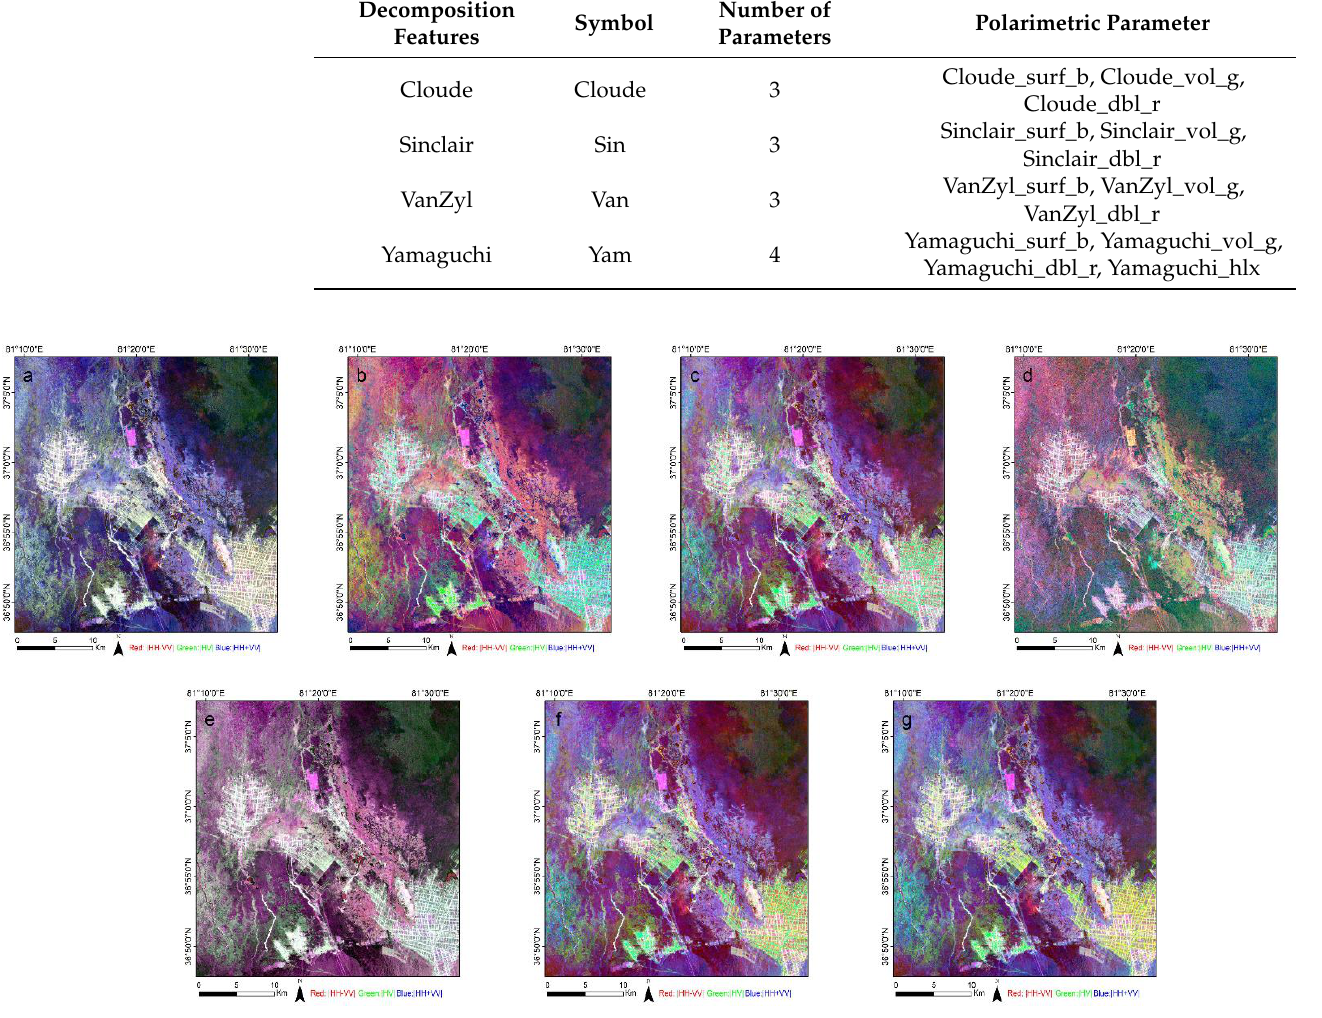
Figure 3. Polarization decomposition results of the RGB standard composite images obtained by different methods: ( a ) Pauli; ( b ) Freeman; ( c ) Freeman Durden; ( d ) Cloude; ( e ) Sinclair; ( f ) VanZyl; ( g ) Yamaguchi.